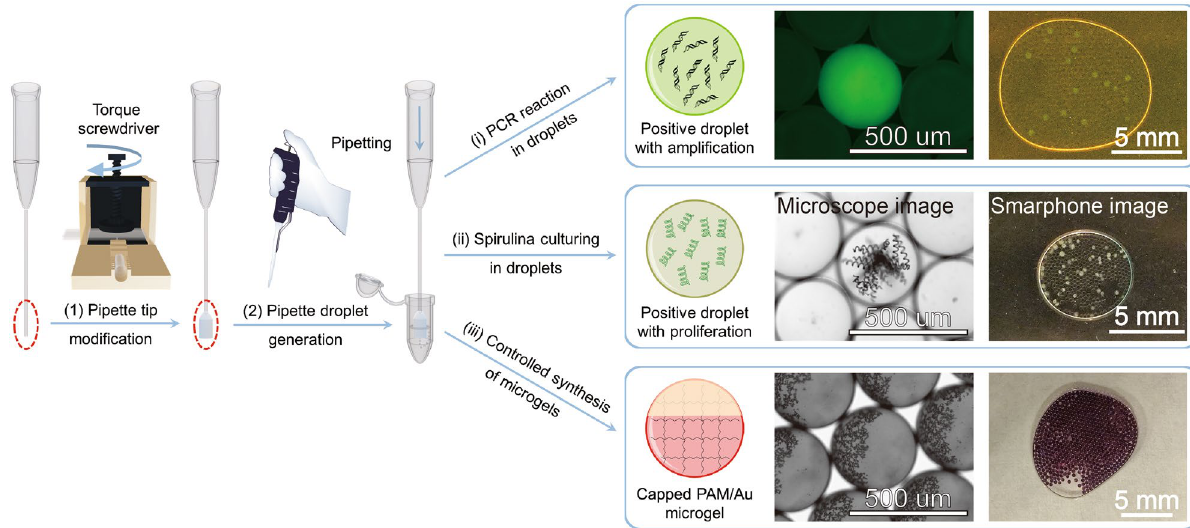
Figure 1. Pipette droplet microfluidics kit: (1) Schematic illustration of controllable pipette tip modification by a torque screwdriver tool results in deformed commercial pipette tips with flattened head parts. The modification will change the original circular orifice of the pipette tip to an elliptical one and the aspect ratio of the elliptical orifice is determined by the torque force from the screwdriver. (2) Droplet generation with the modified tips via a universal micro pipettor. Uniform droplets will pinch-off automatically when dispensing aqueous solution manually through an appropriately deformed pipette tip orifice into fluorinated oil. (i, ii, iii) Examples of typical droplet microfluidics applications about (i) droplet digital PCR with droplets as microreactors, (ii) culturing of spirulina with droplets as microcompartments, and (iii) controlled synthesis of microgels with droplets as the